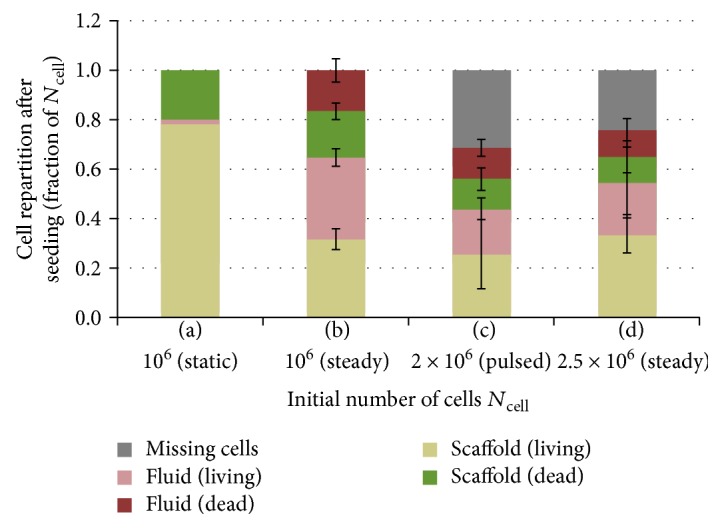
Influence of the initial cell number Ncell and the nature of the flow on the seeding efficiency.